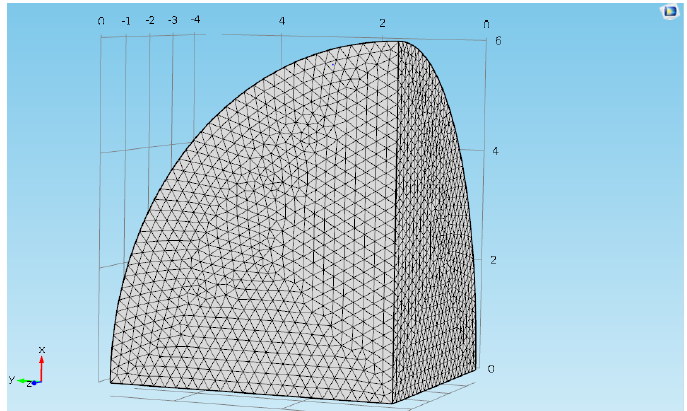
Figure 1. Finite element grid for a single hemp inflorescence particle.